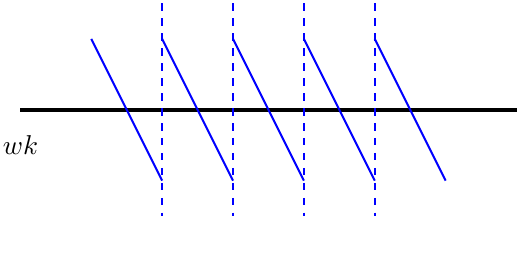
Figure 5 . Spectral